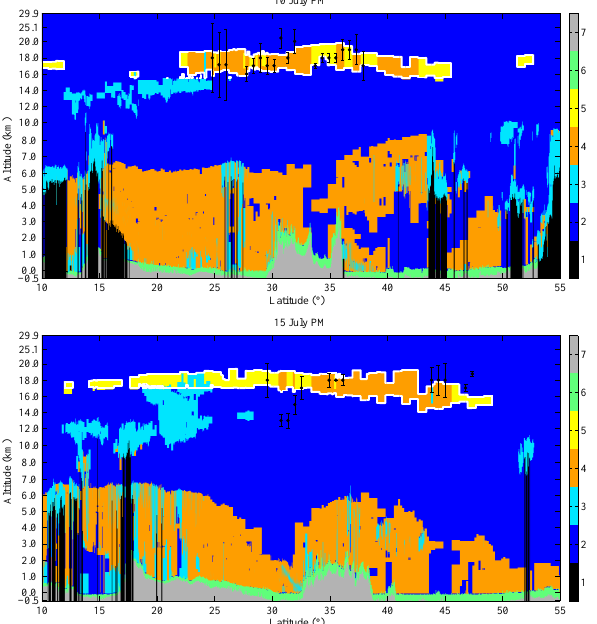
Fig. 14. CALIOP measurements for 10 and 15 July (evening over- pass) over the Middle East and coincident IASI retrievals (see